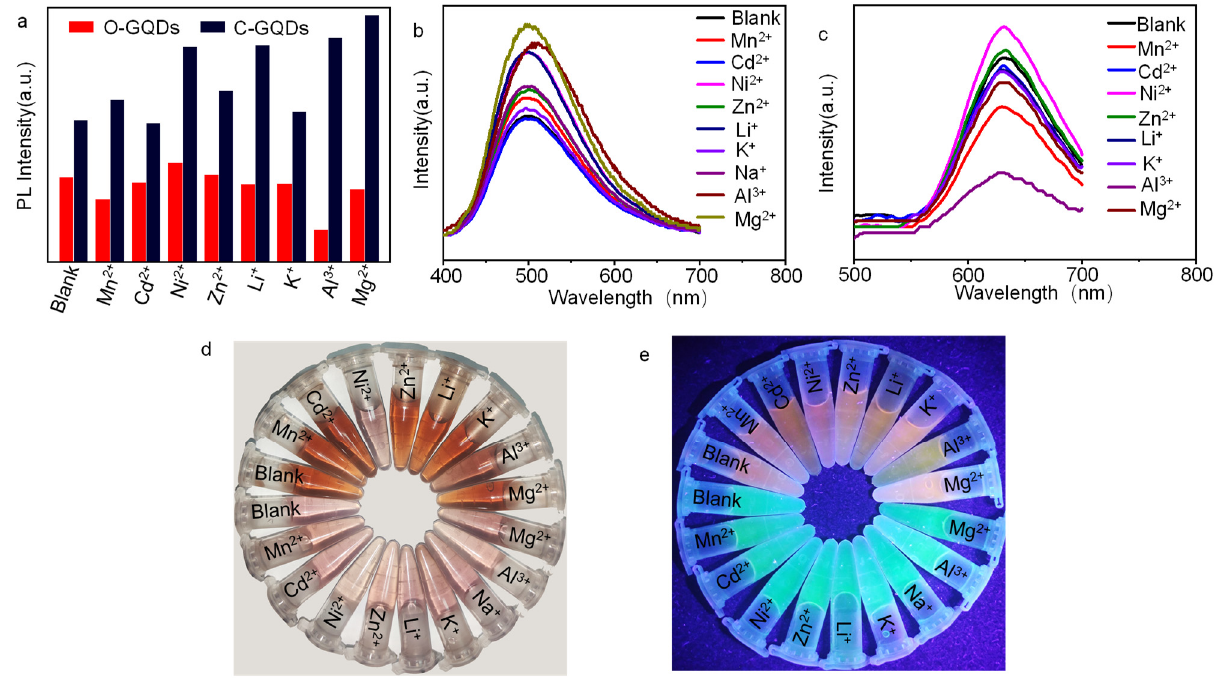
Figure 6. ( a ) The difference in the relative PL strengths of c-GQDs and o-GQDs between blank and solutions containing different metal ions, ( b ) Spectrograms of c-GQDs containing different metal ion solutions, ( c ) spectrograms of o-GQDs containing different metal ion solutions, and ( d , e ) photographs of c-GQDs and o-GQDs containing different metal ion solutions under natural light and ultraviolet light (the c-GQDs solution is lavender under natural light and cyan under UV light, and the o-GQDs solution is brown under natural light and orange under UV light).